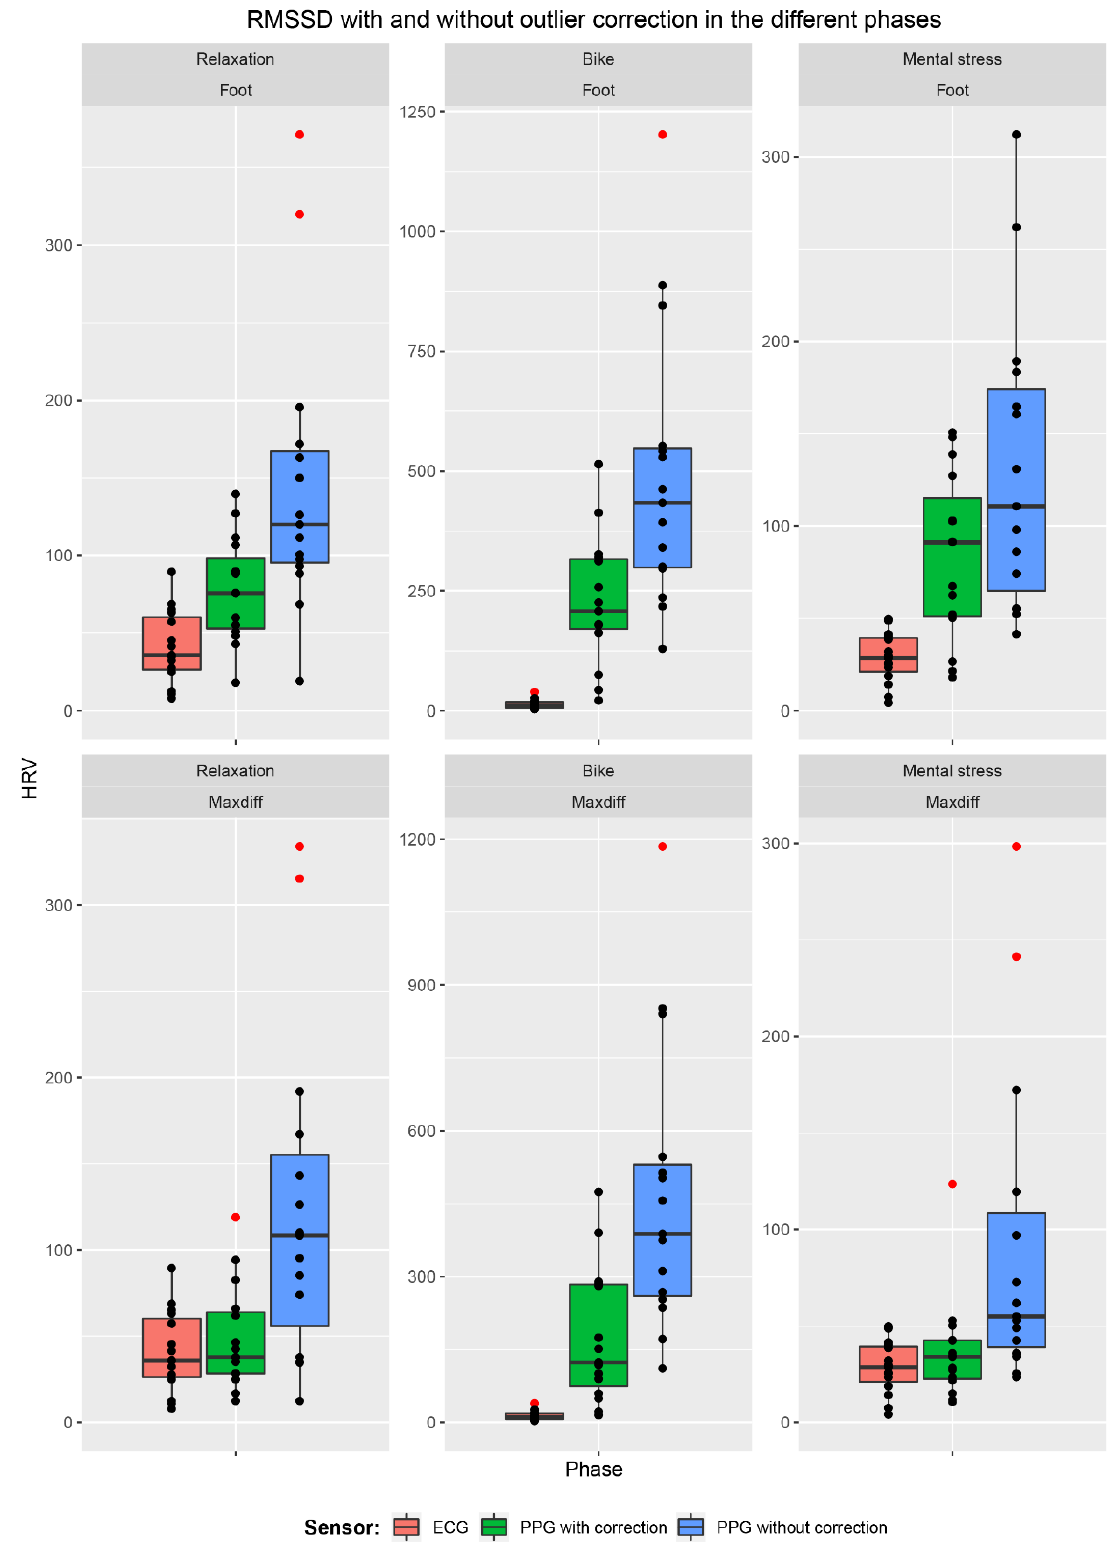
Figure 8. The spread of RMSSD for the 15 participants measured with ECG and PPG with and without outlier correction, broken down by the different phases and fiducial points (foot and maxdiff). Outliers are shown in red.